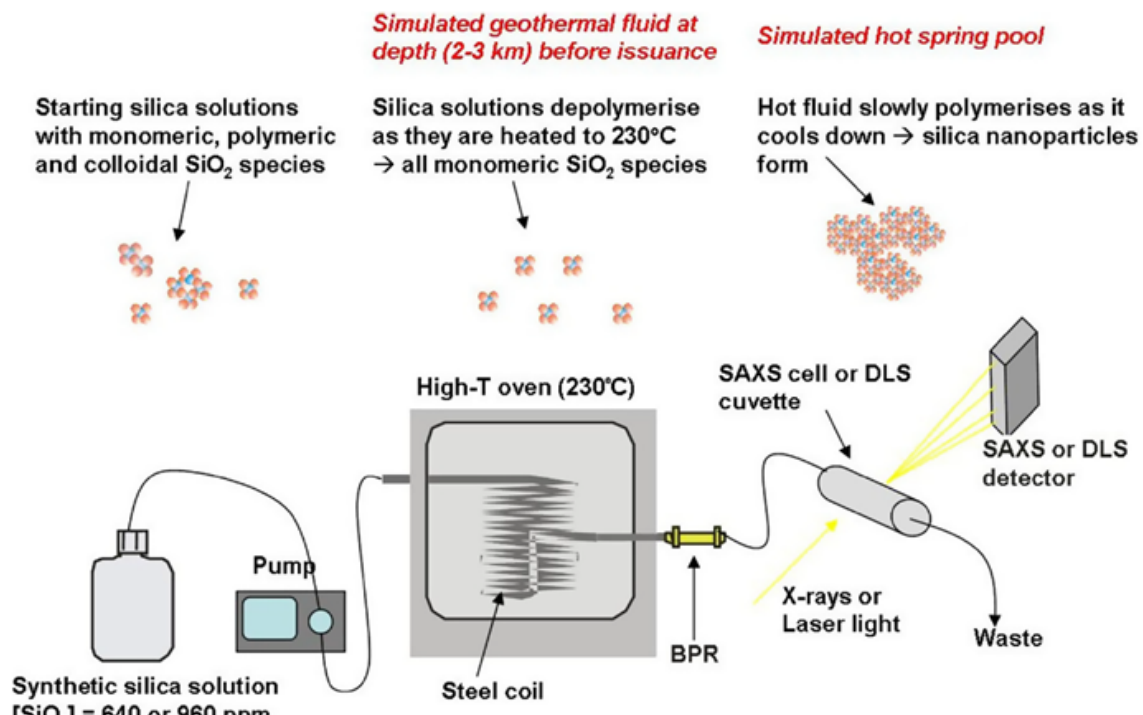
Figure 13: Schematic diagram of experimental set up to simulate a natural geothermal system where silica nanoparticles form via the fast cooling of a supersaturated monomeric silica solution (modified after Benning and Mountain, 2004). The simulator is interlinked with the